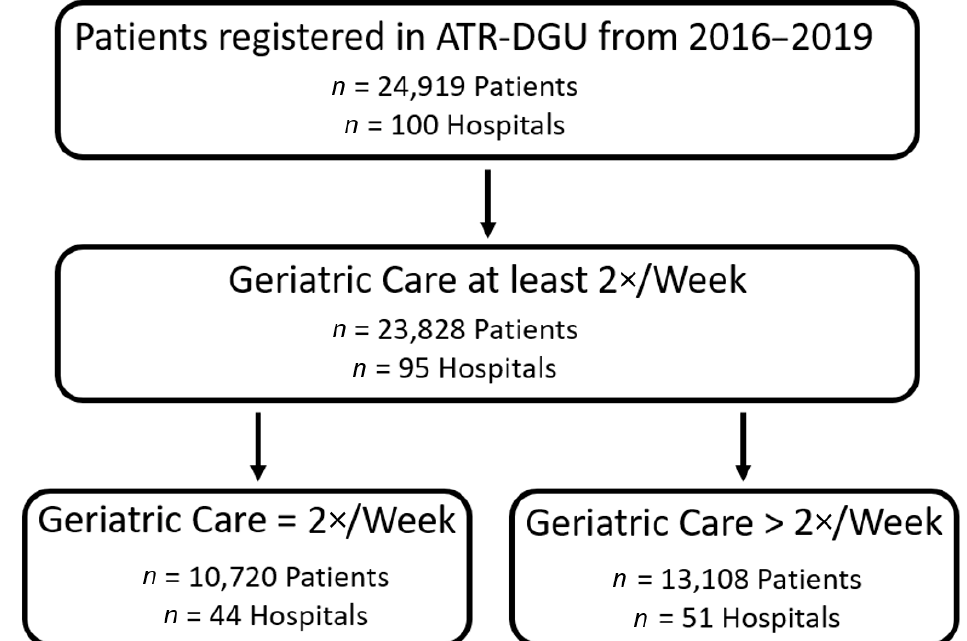
Figure 1. Flow chart presenting inclusion process during study period.